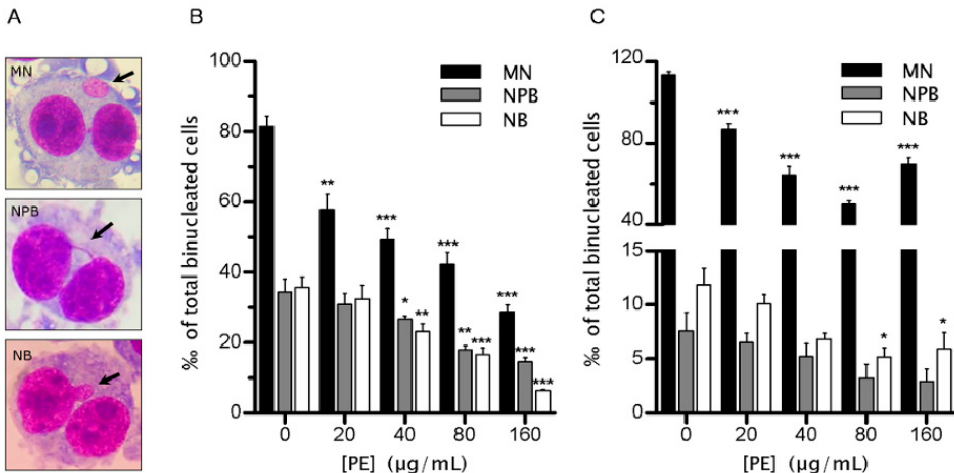
Figure 2. P. emblica (PE) treatment decreased the rate of endogenous genomic instability (GIN) in NCM460 cells. NCM460 cells were treated with PE (20–160 µg/mL) for 72 h, then their endogenous GIN was determined by cytokinesis-block micronucleus assay. ( A ) Representative images of the micronucleus (MN), nucleoplasmic bridge (NPB) and nuclear bud (NB) in binucleated cells (BNC) (indicated by arrows; 100× oil objective, Giemsa staining). Giemsa-stained DNA is in red, and the cytoplasm is in blue; ( B , C ) Frequencies of MN (black bars), NPB (gray bars) and NB (open bars) in control and cells treated with indicated doses of PE were determined in cytochalasin B-induced BNC ( B ) and spontaneous BNC ( C ). Data represent the mean of three independent experiments and SEM. * p < 0.05; ** p < 0.01; *** p < 0.001 vs. untreated control.